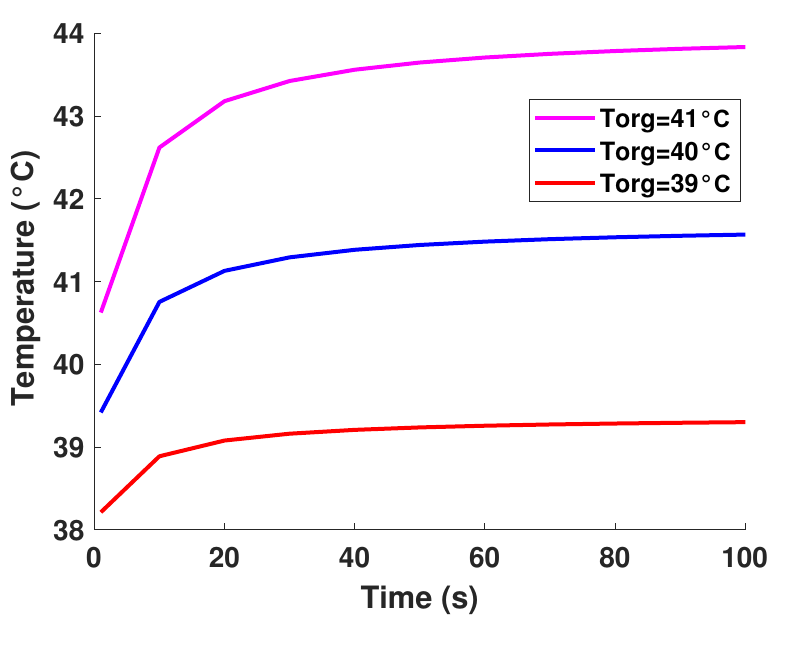
Figure 3. Model-based temperature profiles.